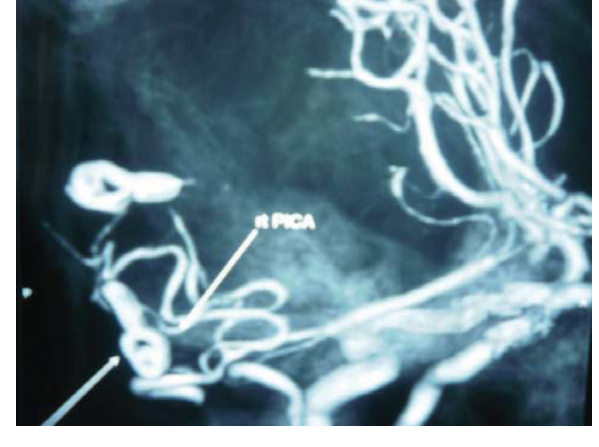
Figure 4. The CT angiogram (lateral view) revealed complete obliteration of the sacs of both the distal PICA aneurysms. The clips are in the normal